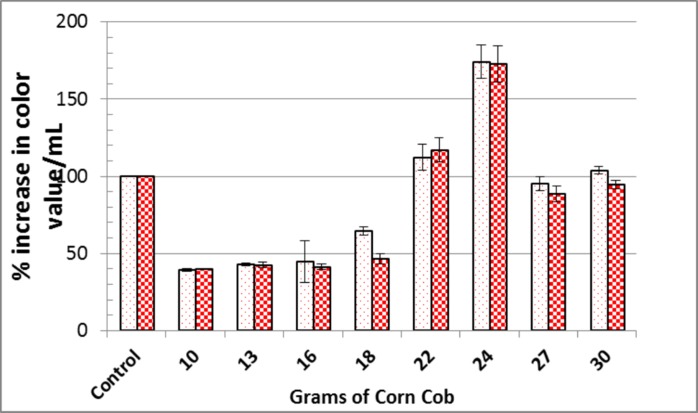
Effect of grams of corn cob added to the fermentation process on orange and red monascus pigments production.Dotted bars: orange moanscus pigments. Checkboard bars: red monascus pigments.